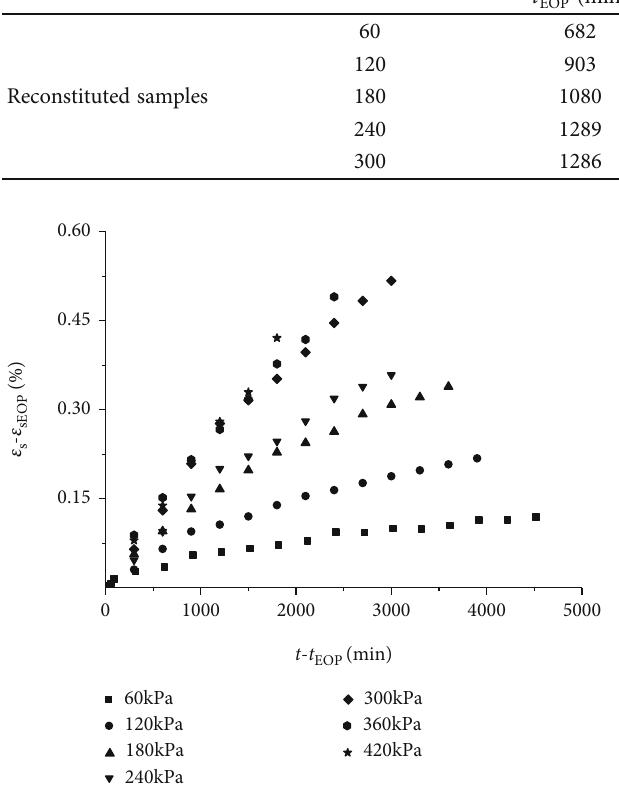
Figure 9: Deviatoric strain creep curve of the intact sample.